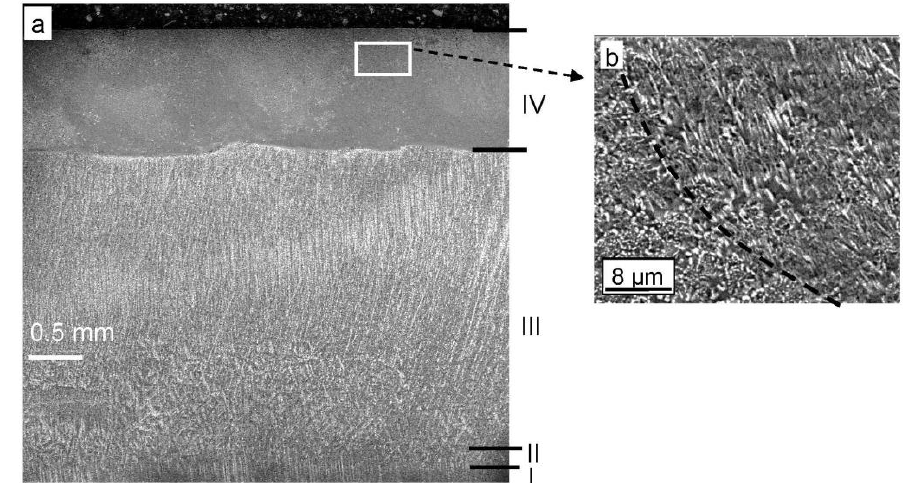
Figure 2. Cross-sectional images of the laser-cladded specimen showing ( a ) the unaffected substrate (I), the heat affected zone (II), the laser melted zone (III), the Ti–20% Si coating (IV); and ( b ) a laser overlapped region.